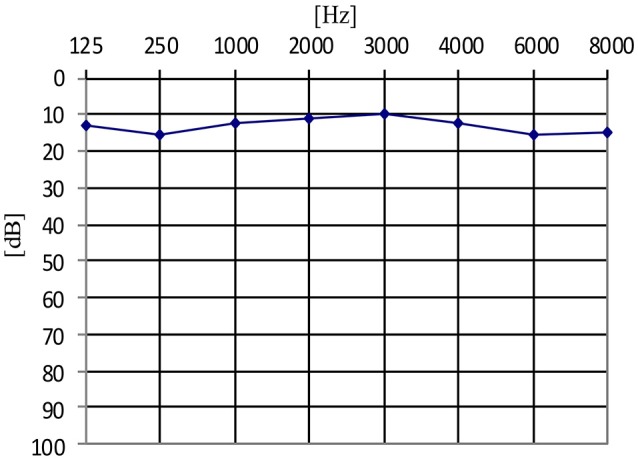
The averaged pure tone audiogram in the healthy students group.